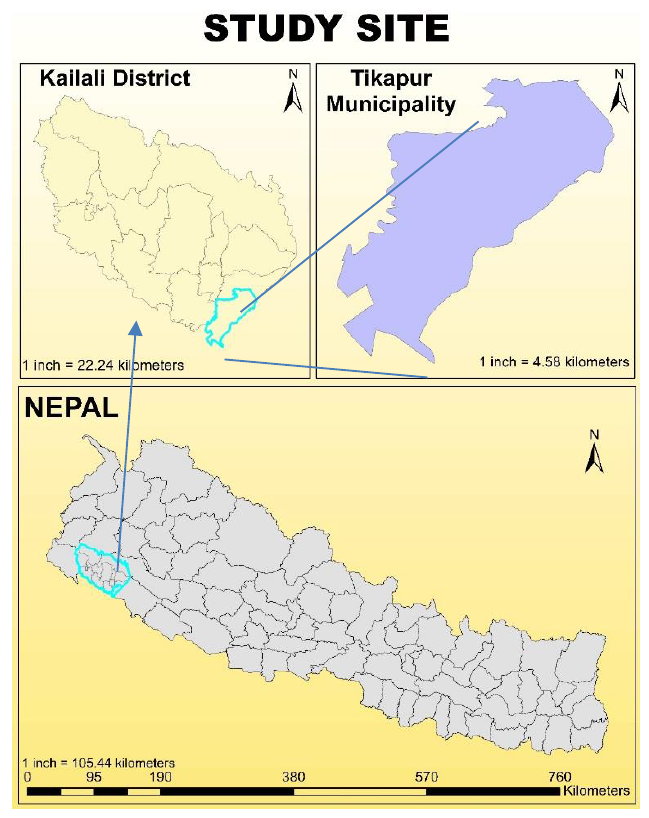
Figure 1: Map of Study